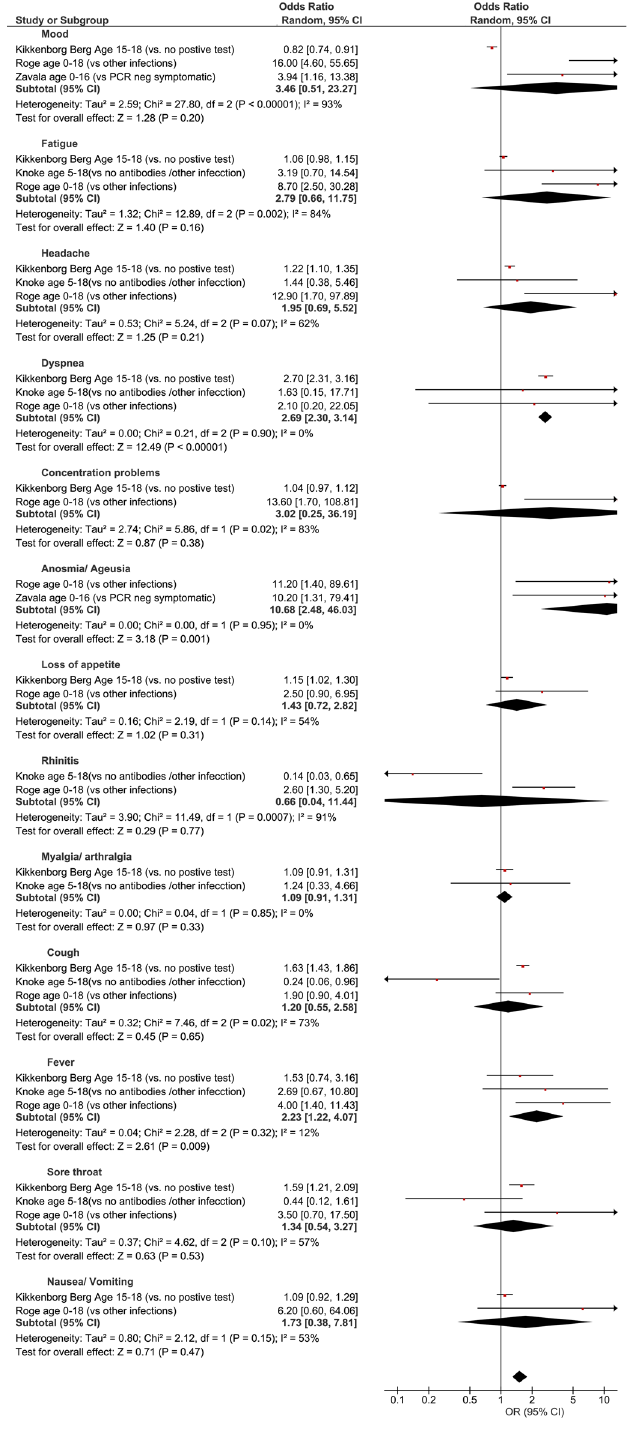
Figure 4. Pooled odds ratios with 95% CI in cases vs. controls. The size of each box indicates the effect of each study by symptom assigned using the odds ratios (95% CI) by age and